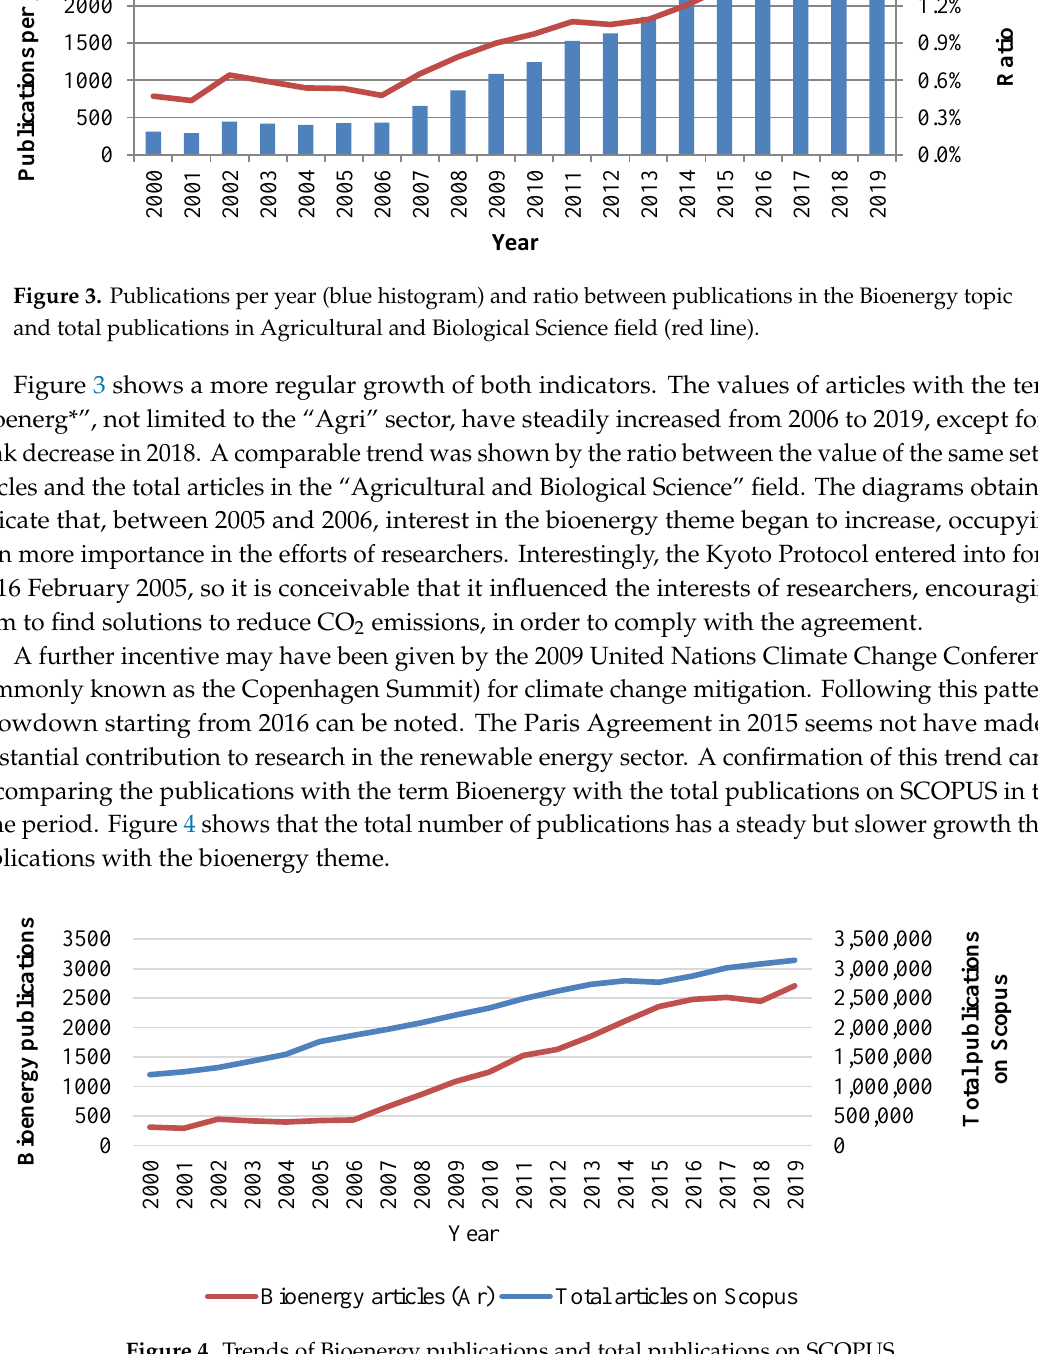
Figure 4. Trends of Bioenergy publications and total publications on SCOPUS.